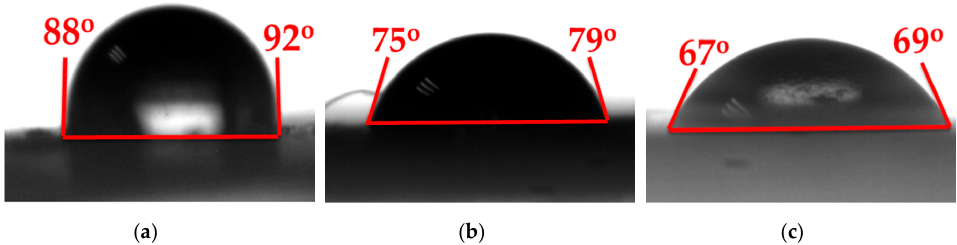
Figure 7. Contact angles of the ( a ) as-received rubber; ( b ) rubber treated at 200 °C with air/nitrogen = 1/4; and ( c ) rubber treated at 250 °C with air/nitrogen = 1/4.